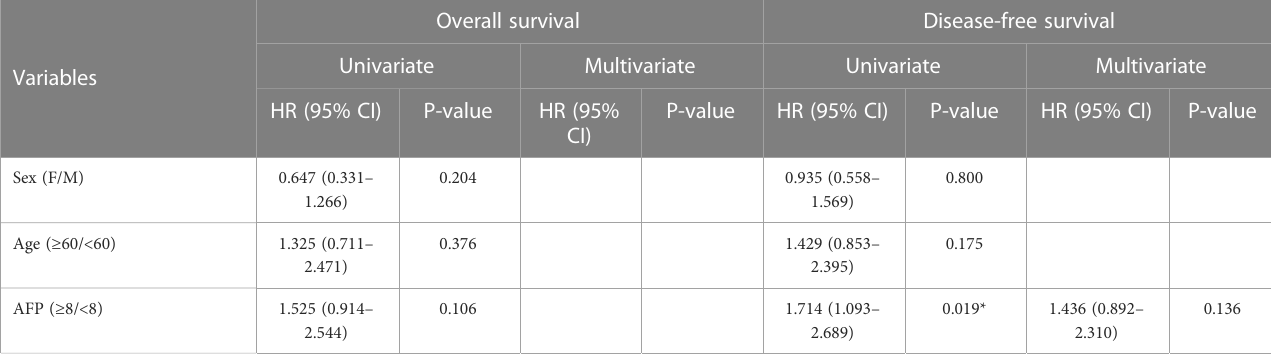
TABLE 3 Identi fi cation of prognostic factors for overall survival and disease-free survival in the training cohort.